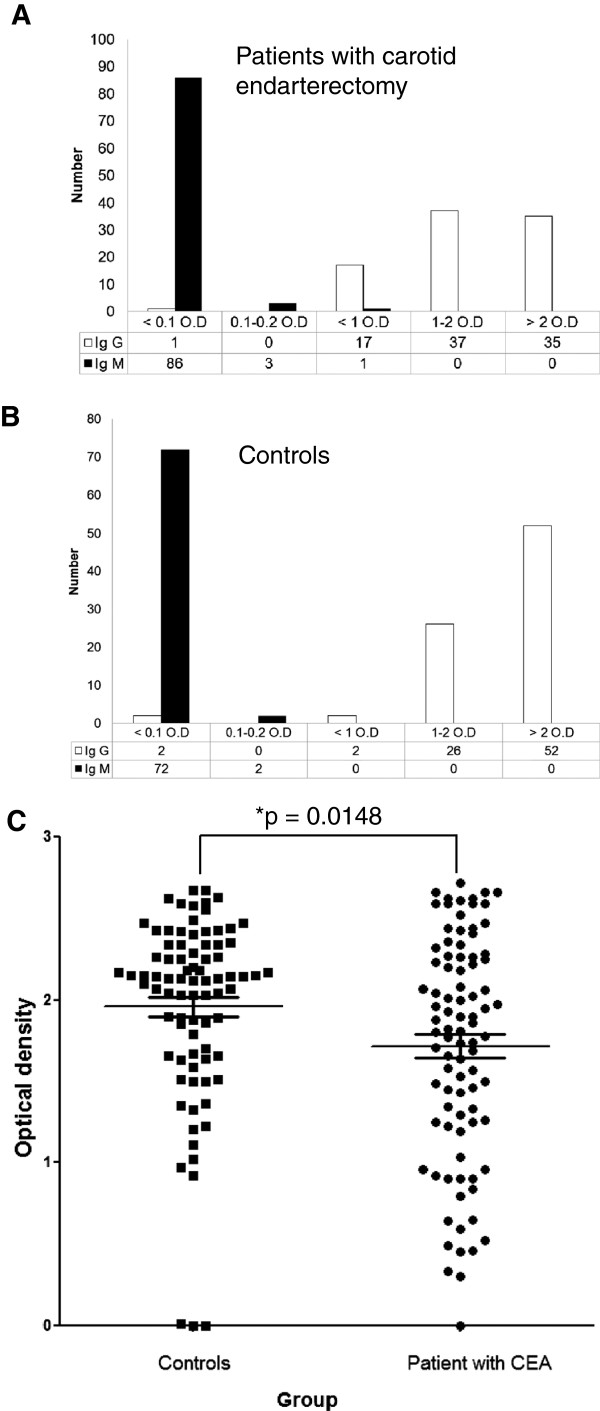
Serological analysis of human cytomegalovirus (HCMV) antibodies in Russian patients with carotid endarterectomy (CEA) and controls. (A) and (B) Bar graphs show seroprevalence of IgG and IgM antibodies against HCMV in patient with CEA or controls, respectively. (C) Scatter plot shows optical density of IgG between patients with CEA and controls. Carotid endarterectomy, CEA; Optical density, O.D.; *p < 0.05.